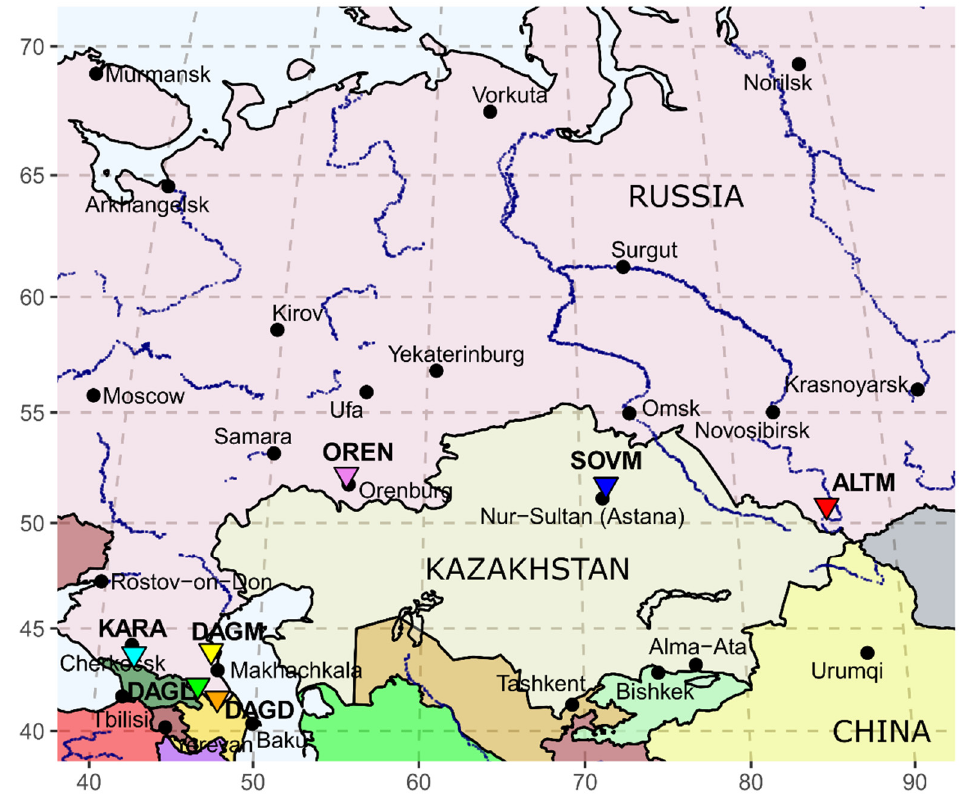
Figure 1. Geographical map showing the sites where seven studied goat populations originated. The goat groups are presented as inverted triangles colored in red for Altai Mountain (ALTM), in orange for Dagestan Downy (DAGD), in pink for Orenburg (OREN), in blue for Soviet Mohair (SOVM), in light green for Dagestan Local (DAGL), in yellow for Dagestan Milk (DAGM), and in turquoise for Karachaev (KARA) breeds.